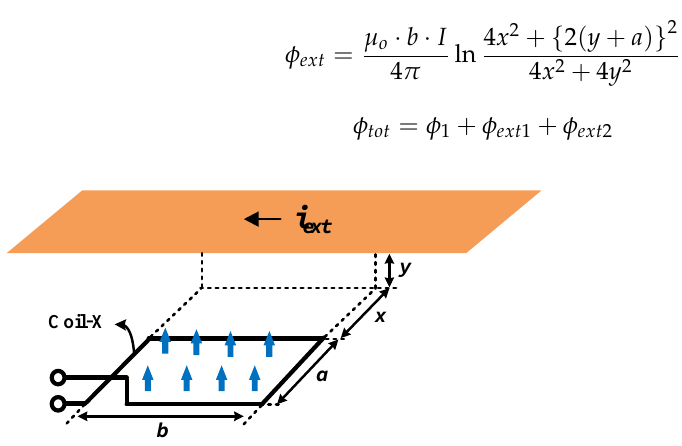
Figure 12. Interference of the external conductor perpendicular to the sensor coil.